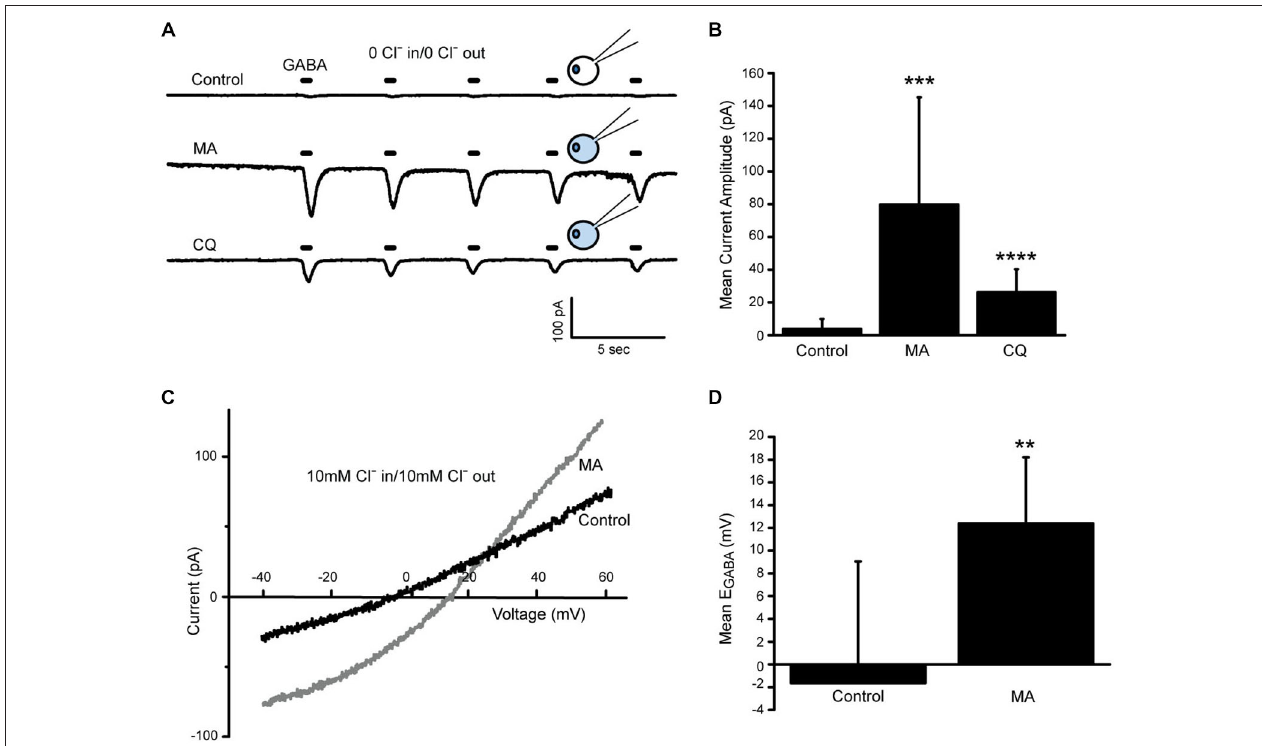
Leak-subtracted GABA-gated currents recorded from two different amacrine cells in 10 mM Cl − internal and external solutions. Currents were elicited by ramping the voltage from –90 mV to +50 mV in the presence of GABA (20 µ M). Recordings were made just after membrane rupture. The control cell has a GABA-gated current reversal potential near the predicted equilibrium potential for Cl − of 0 mV whereas the MA-containing cell’s GABA-gated current reverses at around +15 mV. (D) , Cells recorded with MA had significantly more positive reversal potentials than control. ** denotes p < 0.01, *** denotes p < 0.001, **** denotes p <